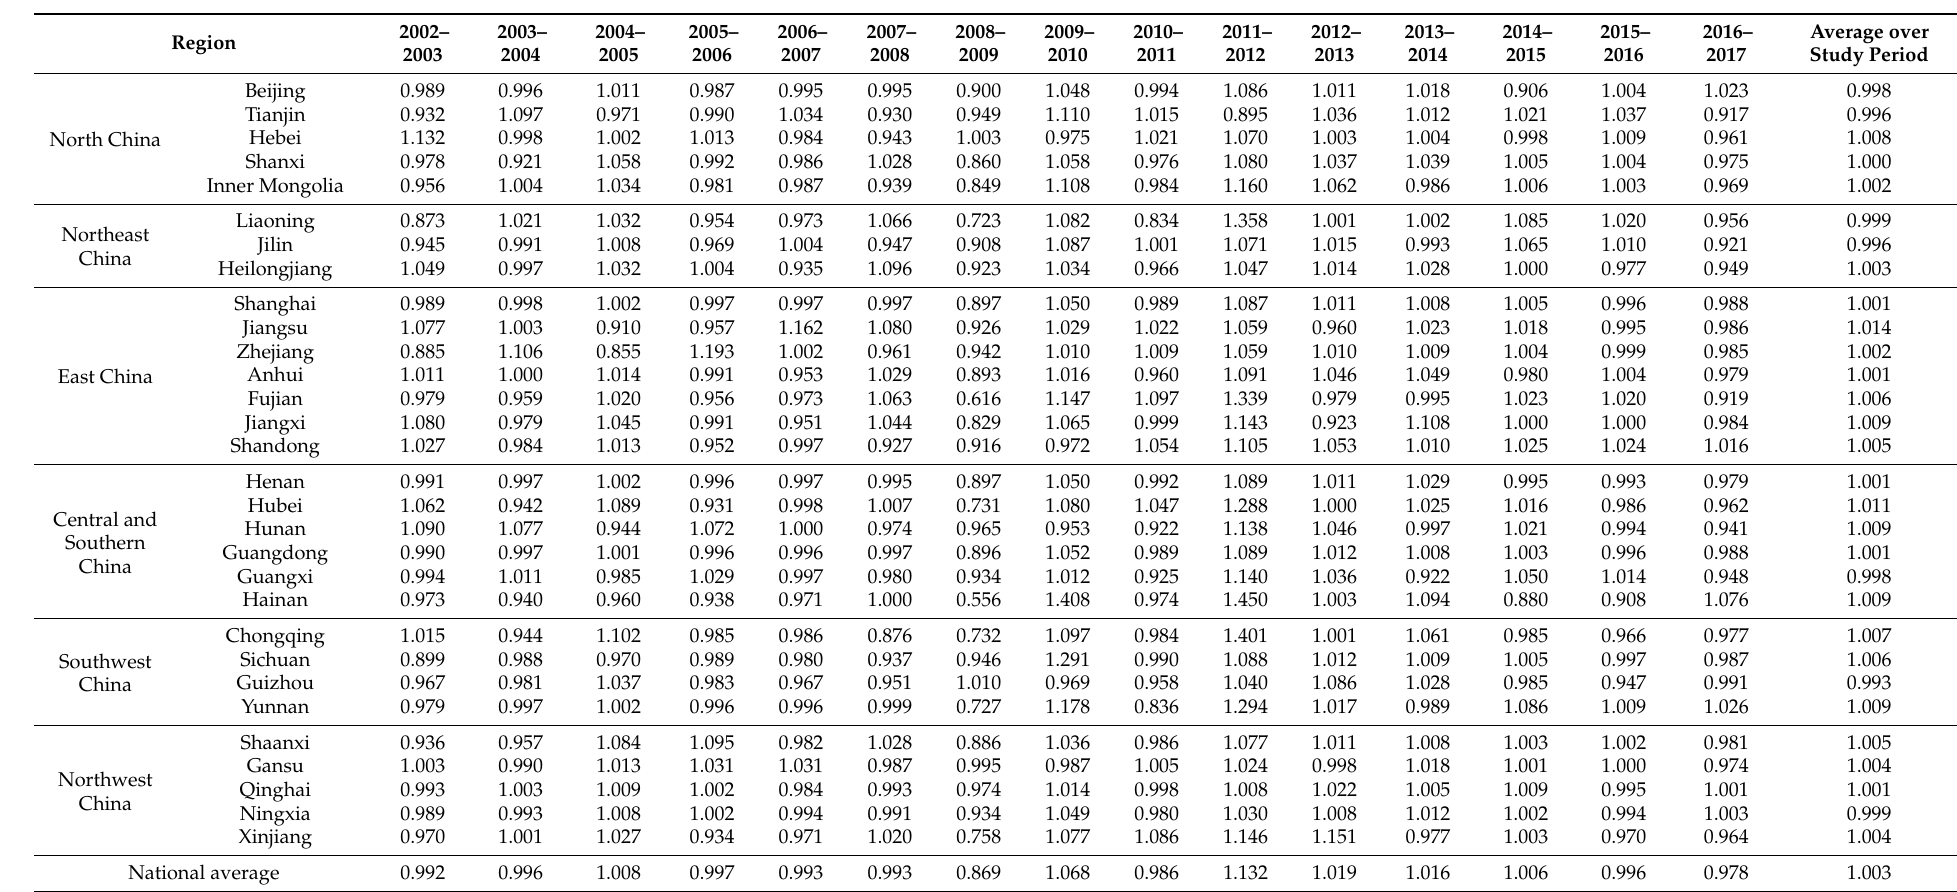
Table A4. Changes of bootstrapped TECI over